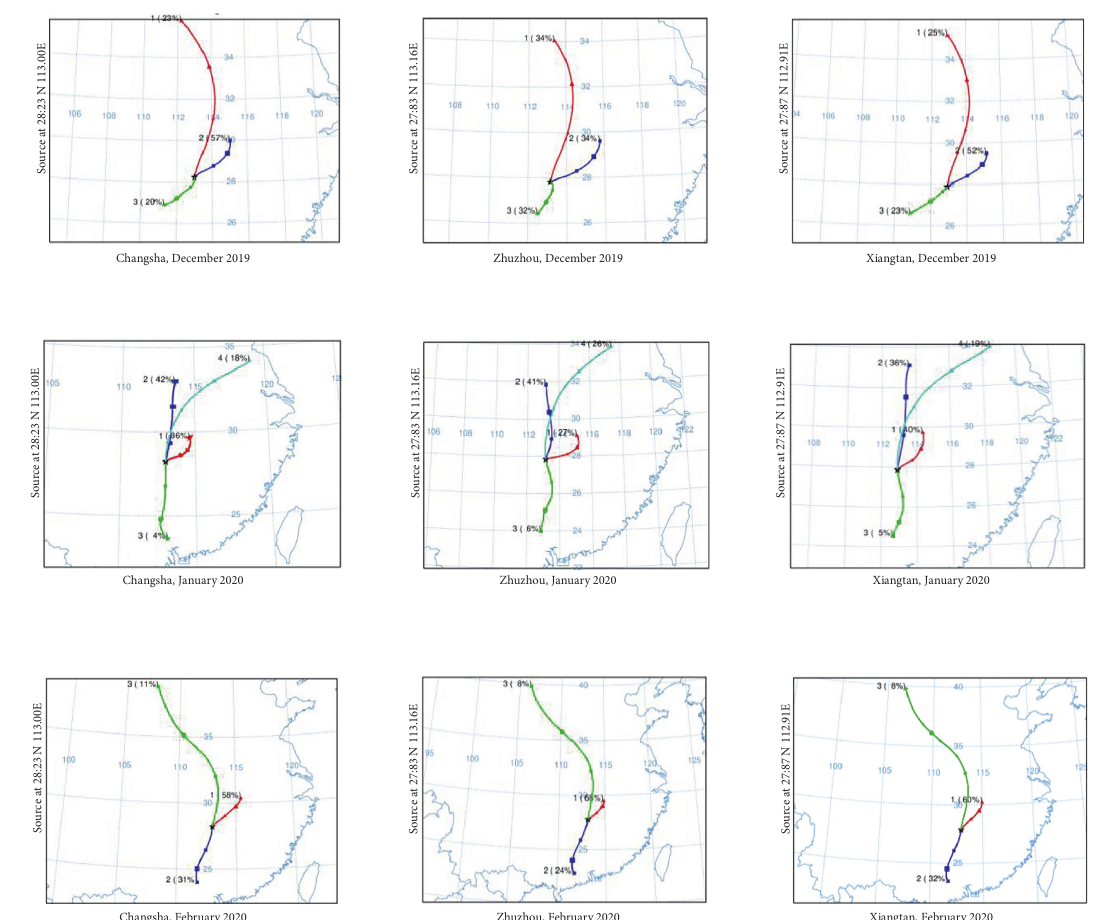
Figure 2: Clustering distribution of backward trajectories from December 2019 to February 2020 in Chang-Zhu-Tan